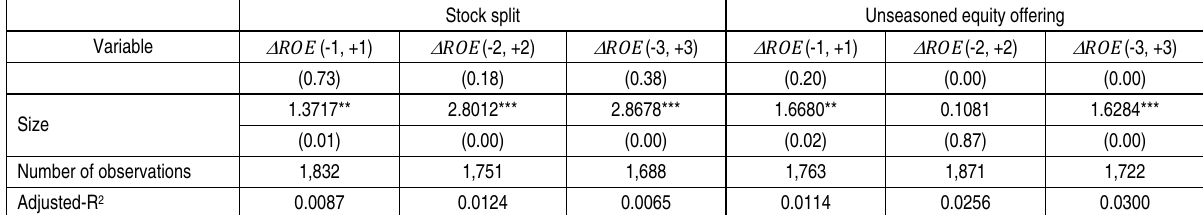
Table 3 (cont.). Difference-in-difference